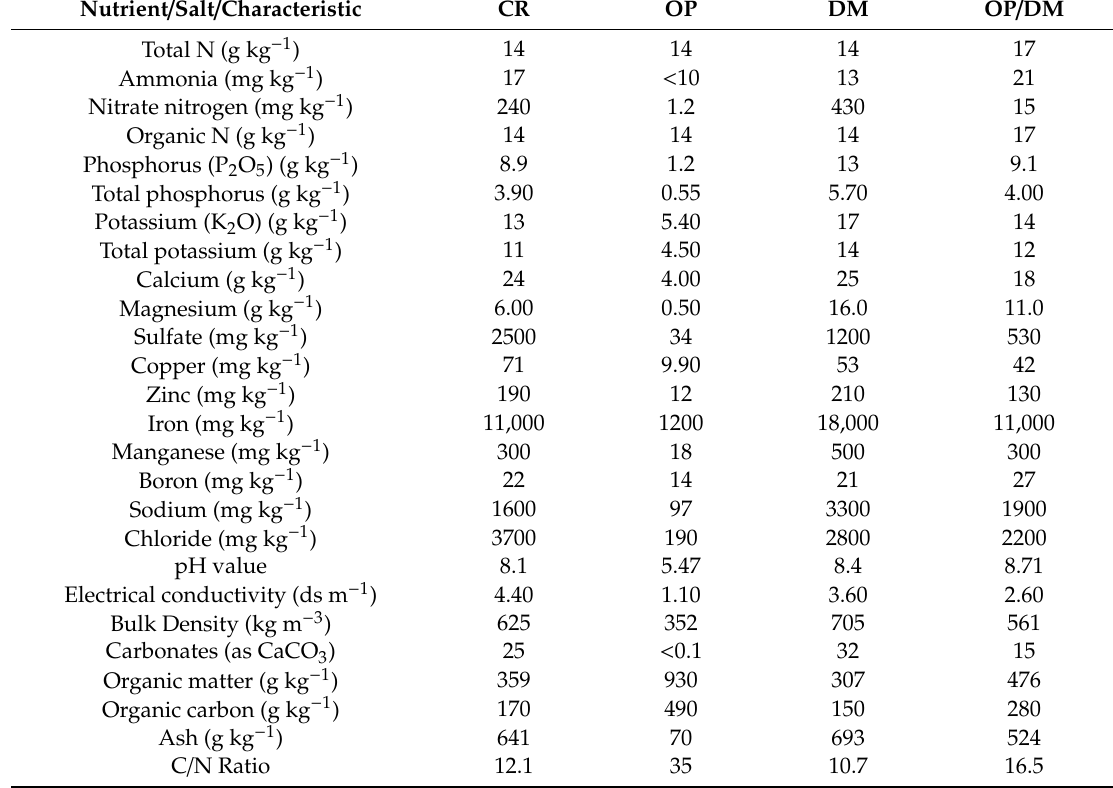
Table 3. Chemical analysis of the composts used in Experiment 3.